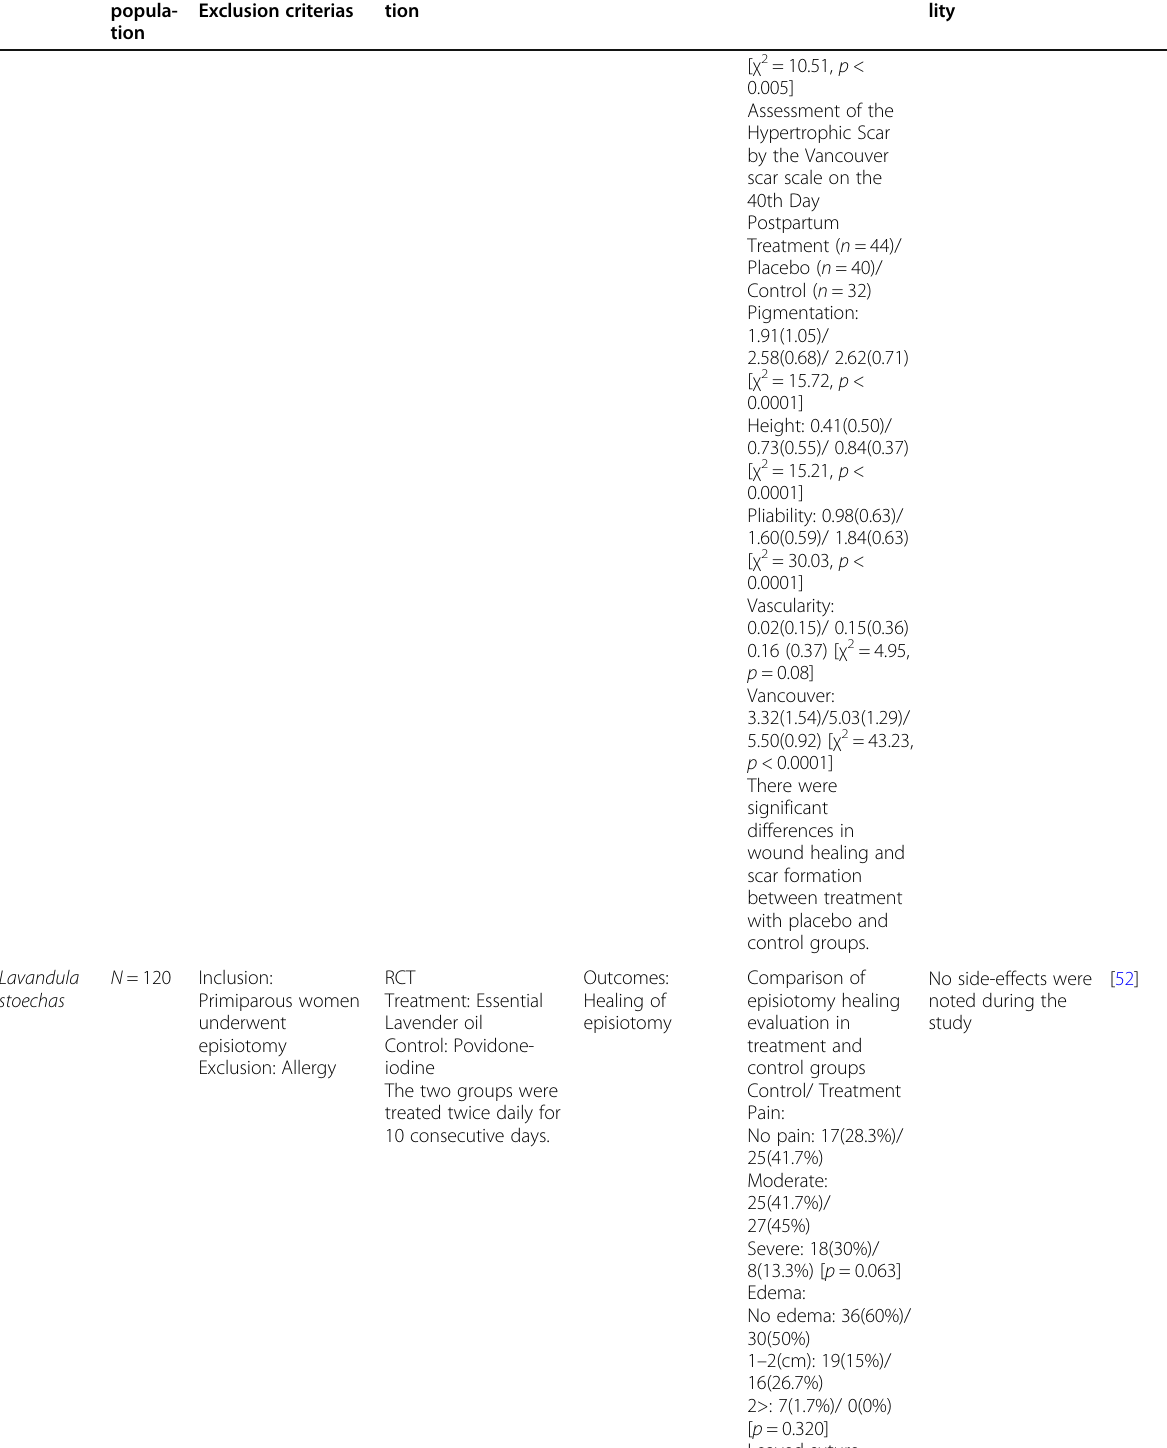
Table 4 Clinical trials of the traditional plants used for skin problems in Turkey (Continued) Study Patient